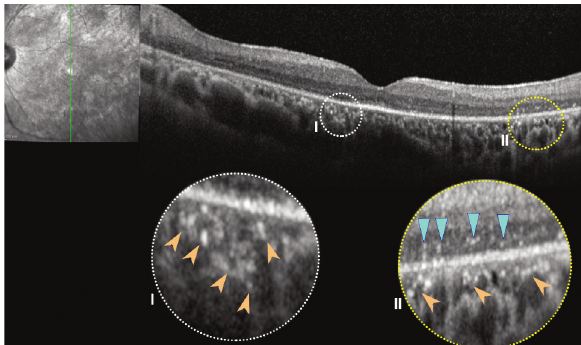
Figure 3: Spectral-domain optical coherence tomography B-scans showing an illustrative case of retinitis pigmentosa characterized by both choroidal hyperreflective foci (insets, peach arrowheads ) and intraretinal hyperreflective foci (inset II, light blue arrowheads